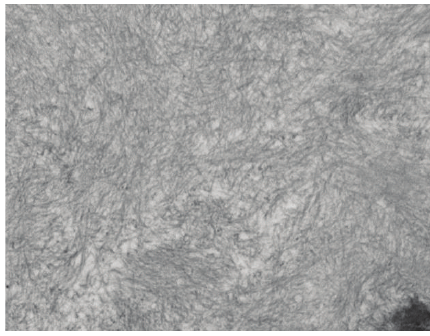
Figure 5: Higher magnification electron microscopy showing clearly the nonbranching fibrils in the wall of a renal vessel.